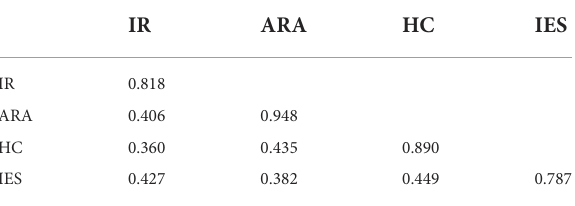
TABLE 4 Model good